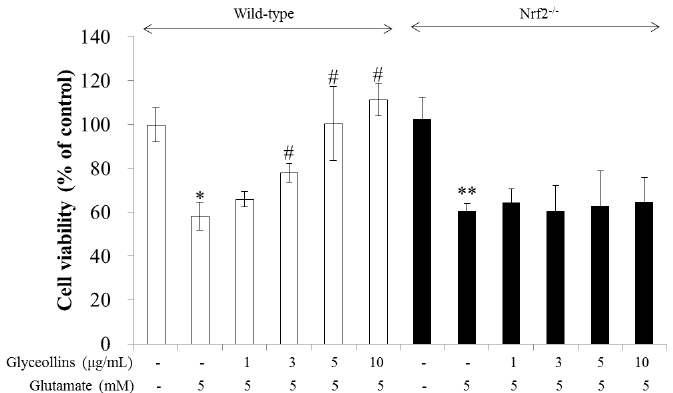
Figure 1. Attenuation of glutamate-induced excitotoxicity by glyceollins in primary cortical neurons. Cortical neurons isolated from fetal brain of C57BL/6 wild-type mice (white bars) or Nrf2 knockout (black bars) mice were treated with 1–10 µ g/mL of glyceollins in the presence of glutamate for 24 h and followed by MTT assay. Bars represent mean ± standard deviation (SD, n = 4). *, **, Statistically significant difference from the untreated control ( p < 0.05). #, Statistically significant difference from the positive control group treated with glutamate alone ( p < 0.05).